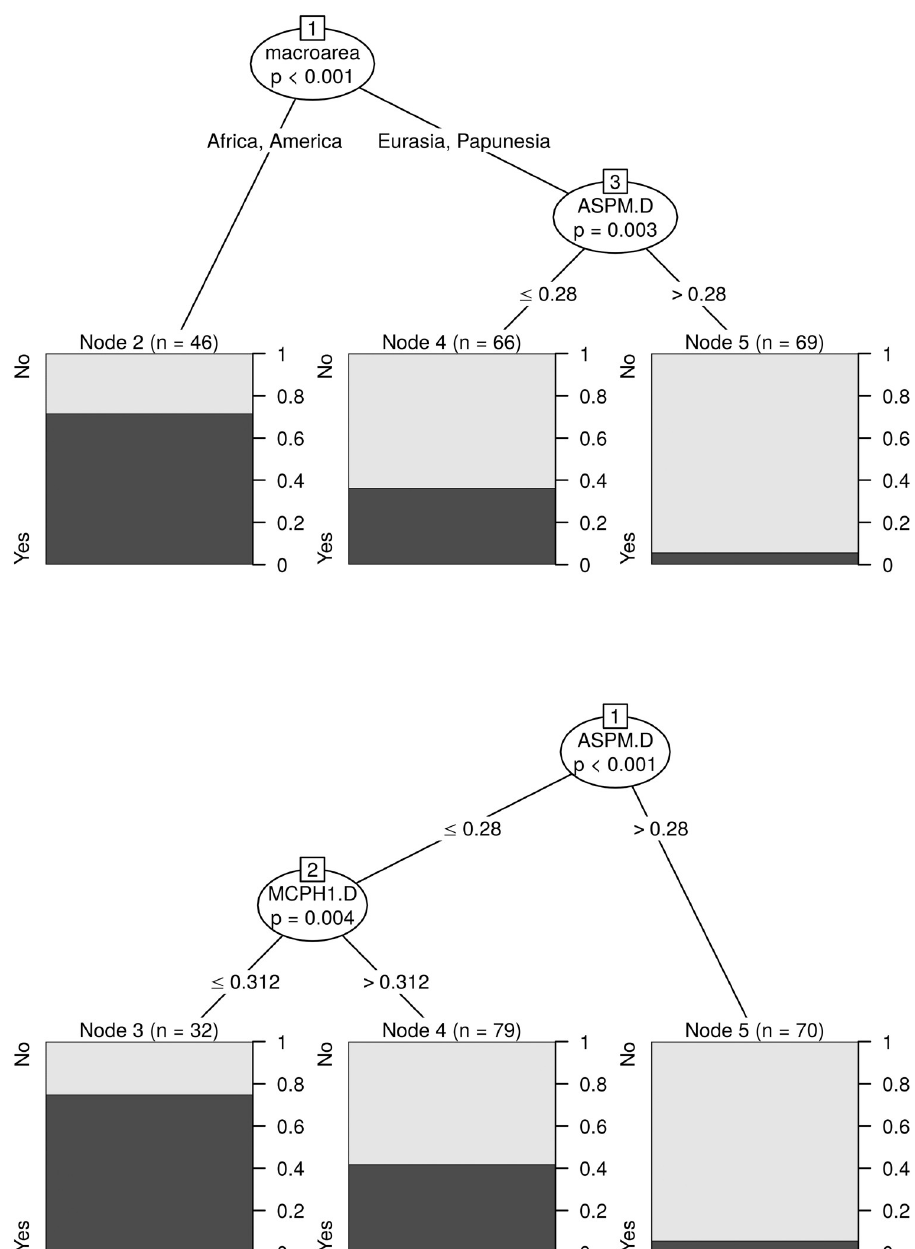
Fig 15. Decision trees for tone1 including macroarea as a predictor (top) or not (bottom). Please note that in these decision tree plots “ASPM.D” and “MCPH1.D” stand for ASPM -D and MCPH1 -D, respectively. Each split is a binary decision based on the values or conditions on the branches (with the p -value in parentheses). The bars at the bottom of the plots show the distribution of “No” (light gray’) and “Yes” (dark gray) values and the number of observations for that case (e.g., n = 69 in the top panel’s rightmost bar, means that 69 observations are in Eurasia and Papunesia with the population frequency of ASPM -D > 0.28, and for those only a minority of � 6% have tone). It can be seen that in the bottom panel, a low frequency of MCPH1 -D seems to be a proxy for